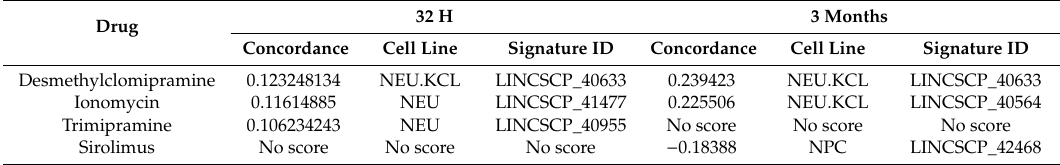
Table 1. Concordance value, cell line from which the data were derived and signature ID in the iLINCS analysis. Gene expression signatures were assessed in the expression datasets of the perilesional cortex obtained at 32 h and 3 months